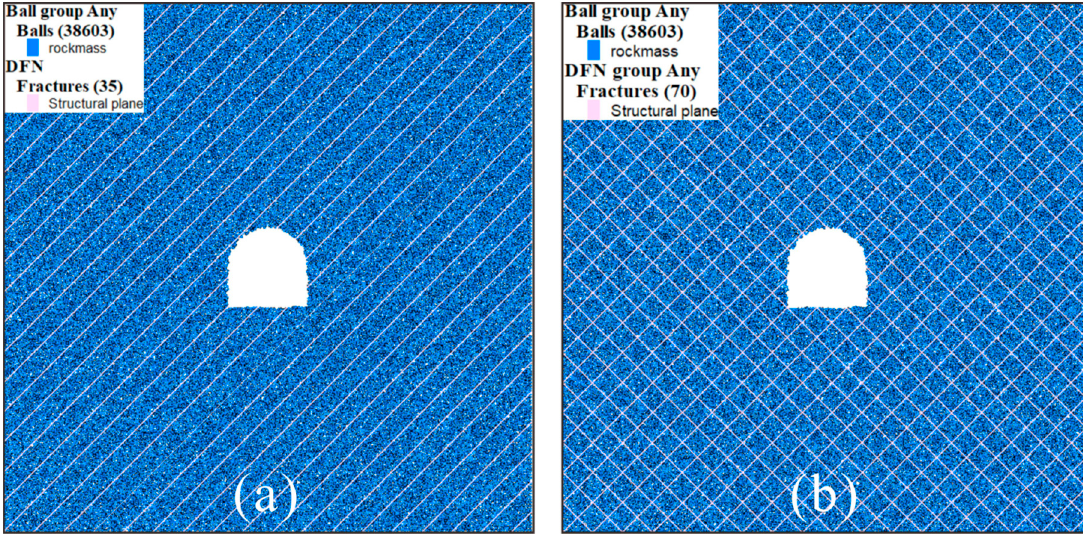
Figure 6. Rock mass model of different models. ( a ) Layered rock mass; ( b ) rhomboid rock mass. DFN (Discrete fracture network).